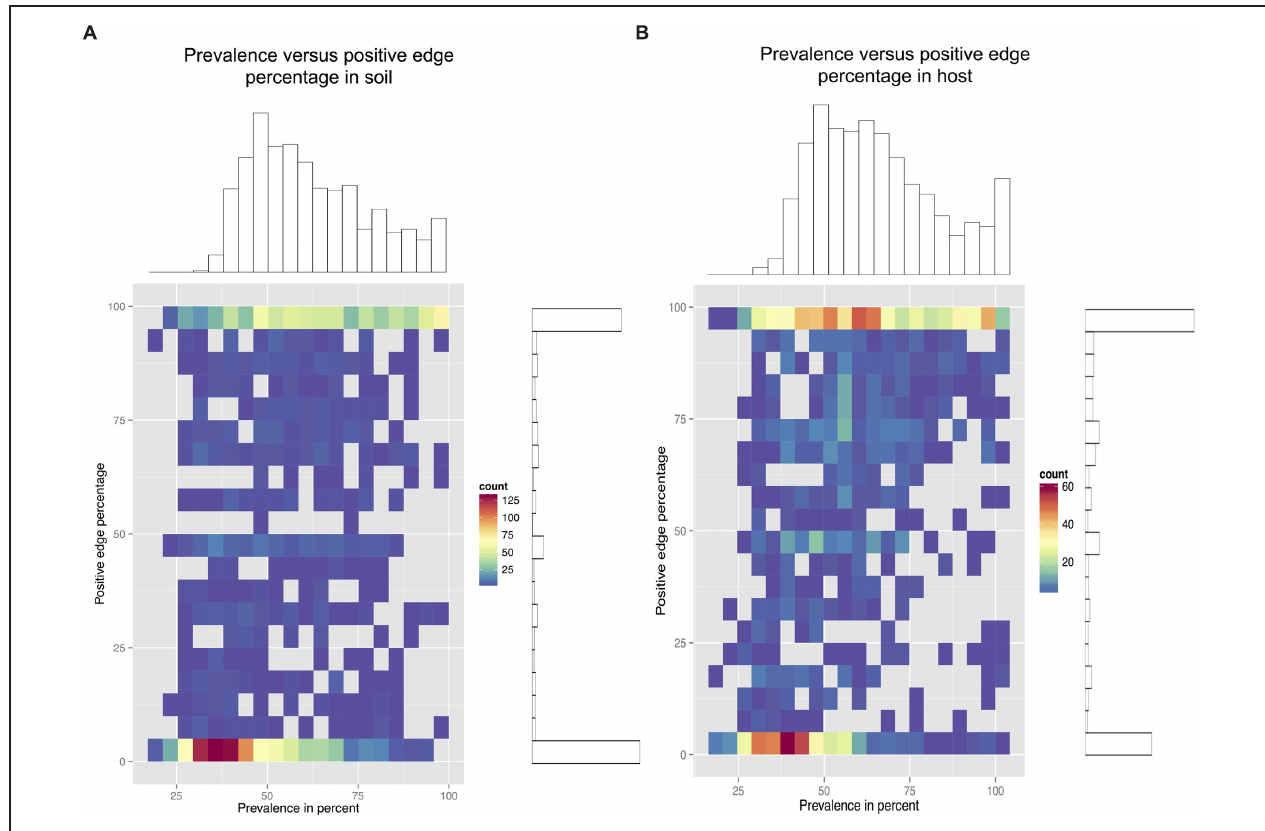
FIGURE 6 | Prevalence density plots. The prevalence (measured as the percentage of occurrence across samples) and PEP in soil networks (A) and host networks (B) is divided in 20 bins and each node is placed in its bin combination. On the right and top of each density plot, the node-specific PEP and prevalence histograms are shown. In soil networks, node PEP tends to be low at lower prevalence, whereas in host networks, low PEP at low prevalence is balanced by high PEP at higher